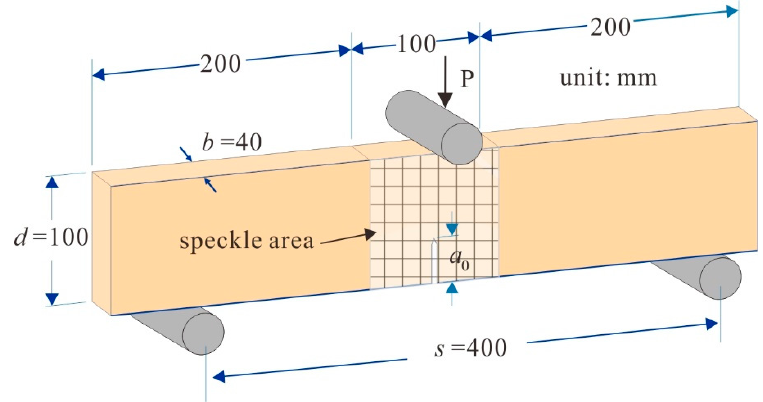
Figure 1. Specimen geometry and loading condition.